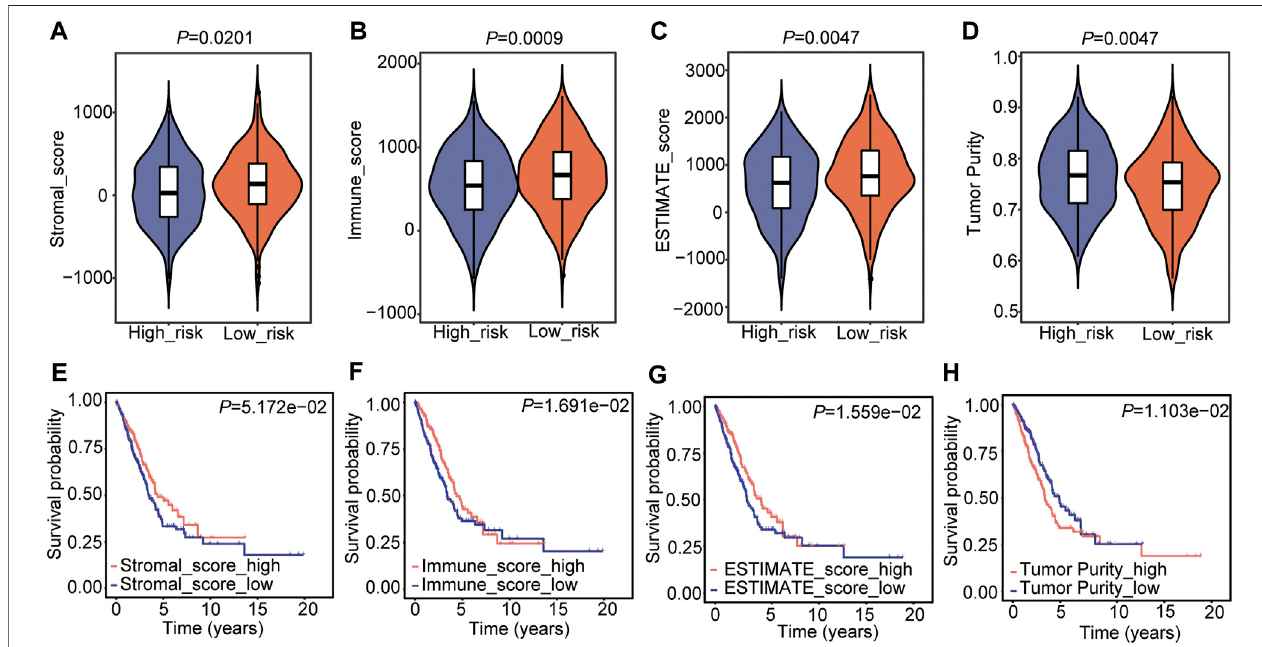
FIGURE 6 | Tumor microenvironment estimation of the Cox model. (A – D) Comparison of the stromal score (A) , immune score (B) , estimate score (C) , and tumor purity (D) in the two risk groups. The statistical signi fi cance was calculated via the Wilcoxon rank-sum test. (E – H) The relationship between stromal score (E) , immune score (F) , estimate score (G) , and tumor purity (H) and OS in